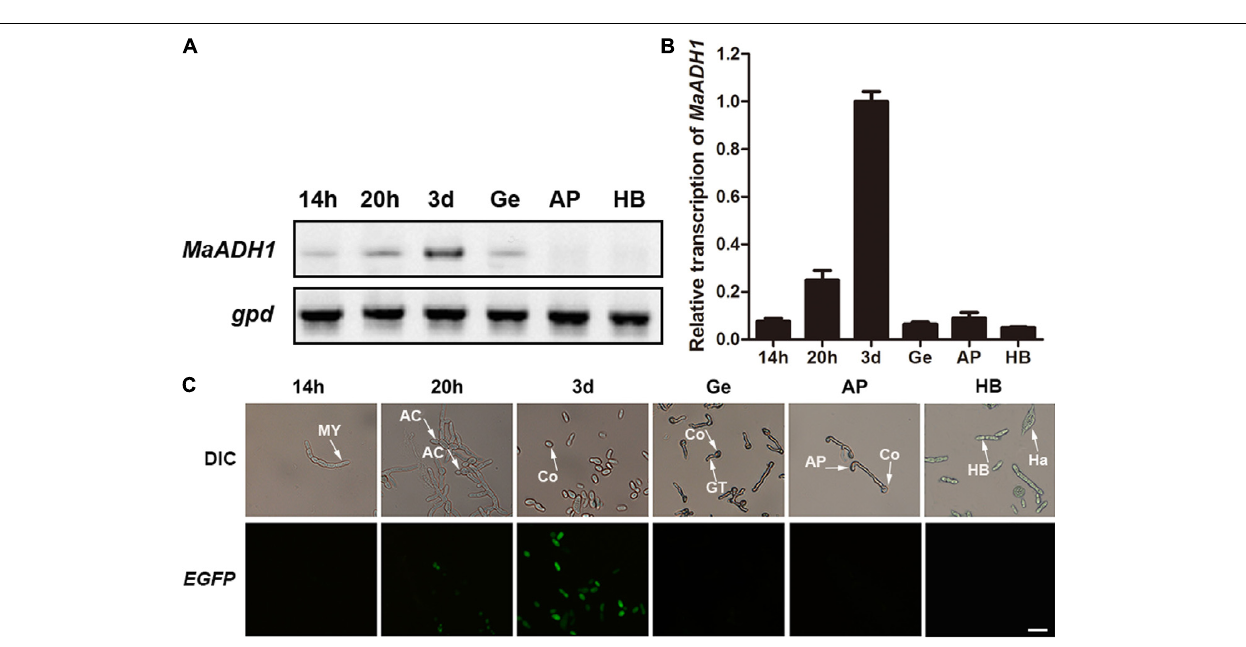
FIGURE 1 | Transcription and enzyme activity. (A) Dissolved oxygen under normal and low oxygen condition. (B) Relative expression of MaADH1 under hypoxic condition and normal condition. (C) ADH activity at different growth time under hypoxic condition and normal condition. A, B indicate significant difference at p < 0.01.